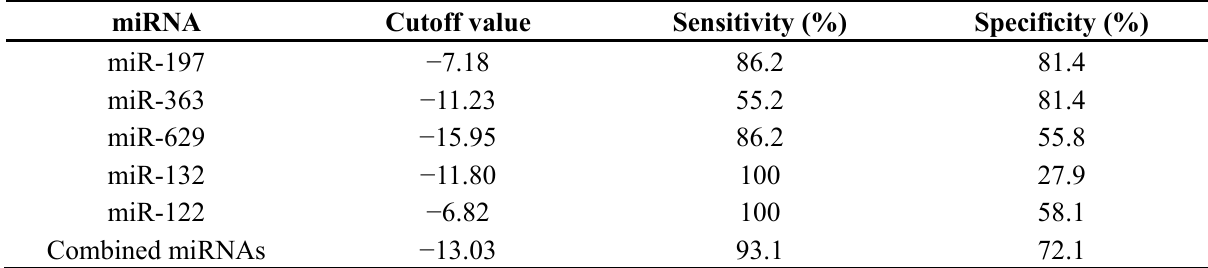
Table 2. The sensitivity and specificity of each candidate miRNA and the combination of five miRNAs to diagnose varicella with an optimal cutoff value.